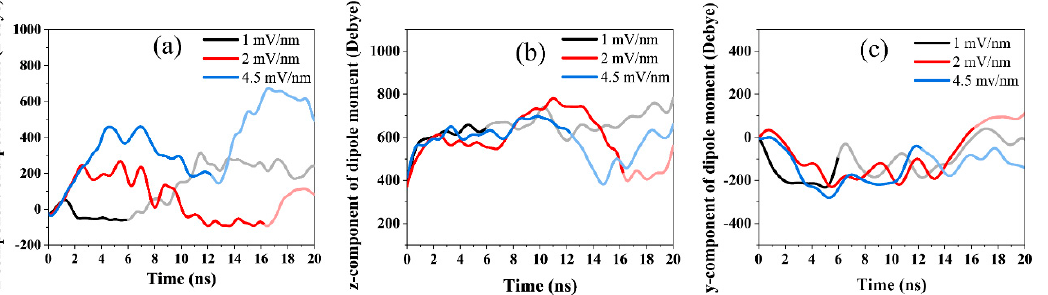
Figure 8. The x-component ( a ), z-component ( b ), and y-component ( c ) of the dipole moment of CNF exposed to various electric field strengths along the x-direction. (The first part of the orientation to align the CNF from the initial angle to the Cartesian x-axis is denoted by bright black, red, and blue colors. The faded black, red, and blue denote the second part of the CNF’s orientation to align its chain length parallel to the EF’s direction).